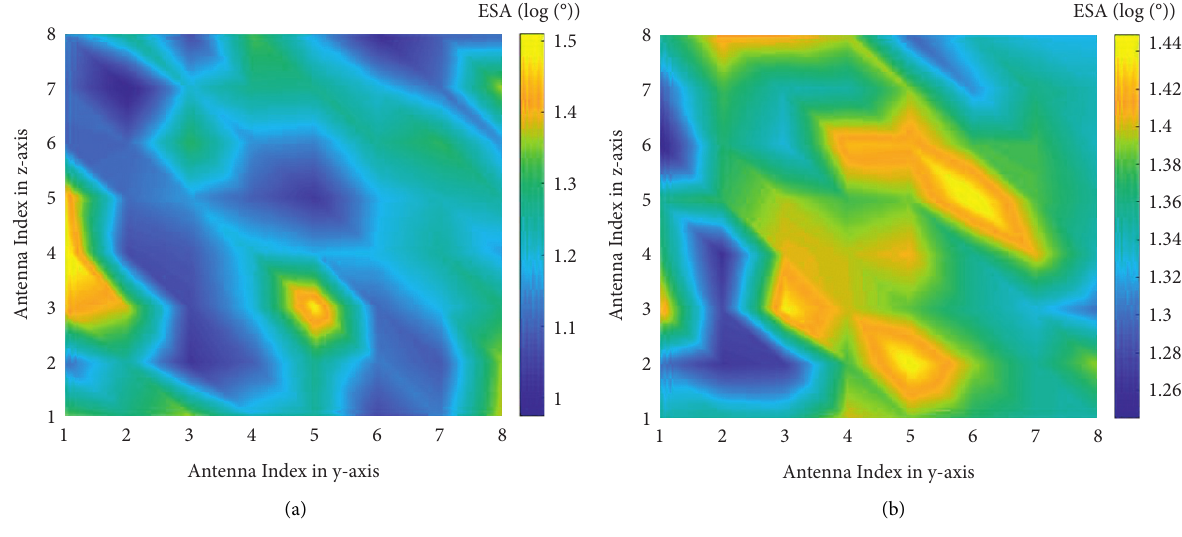
Figure 9: RMS ESA. (a) RMS ESA of Rx-8. (b) RMS ESA of Rx-27.